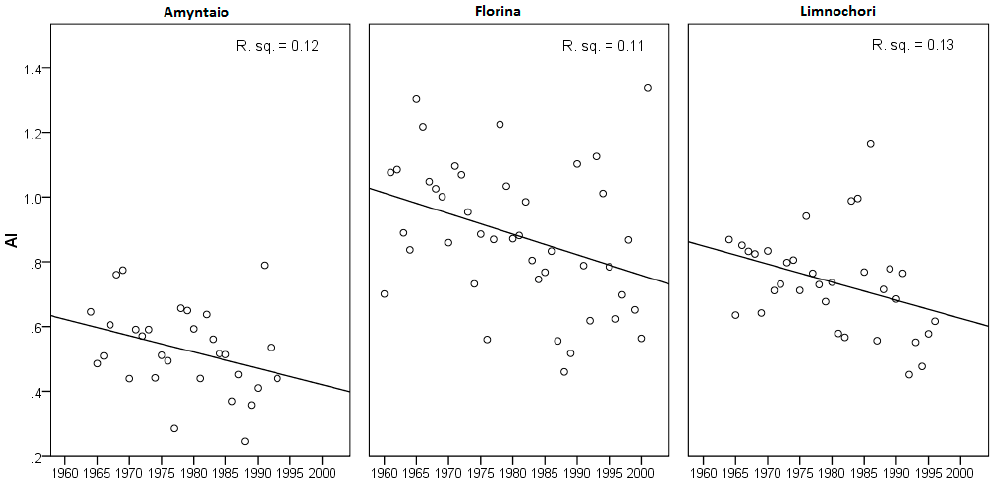
Figure 3. Aridity Index ( AI ) trends in the studied area ( AI calculated using data from three meteorological stations).